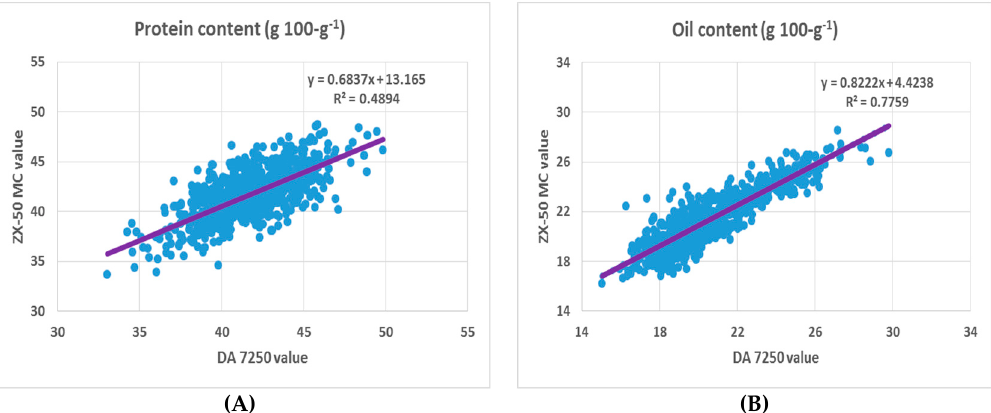
Figure 1. Correlation between near-infrared (NIR) analysis methods DA 7250 and ZX-50 MC in predicting soybean seed protein ( A ) and oil ( B ) content.